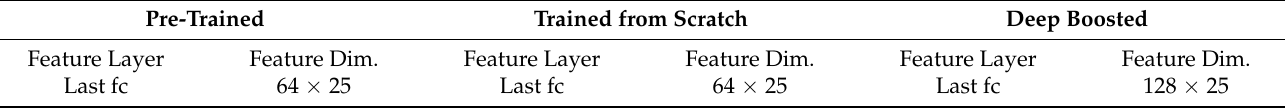
Table 3. Deep feature matrix dimensions for each CNN model. Pre-Trained Trained from Scratch Deep Boosted Feature Layer Feature Dim. Feature Layer Feature Dim. Feature Layer Feature Dim. Last fc 64 × 25 Last fc 64 × 25 128 ×